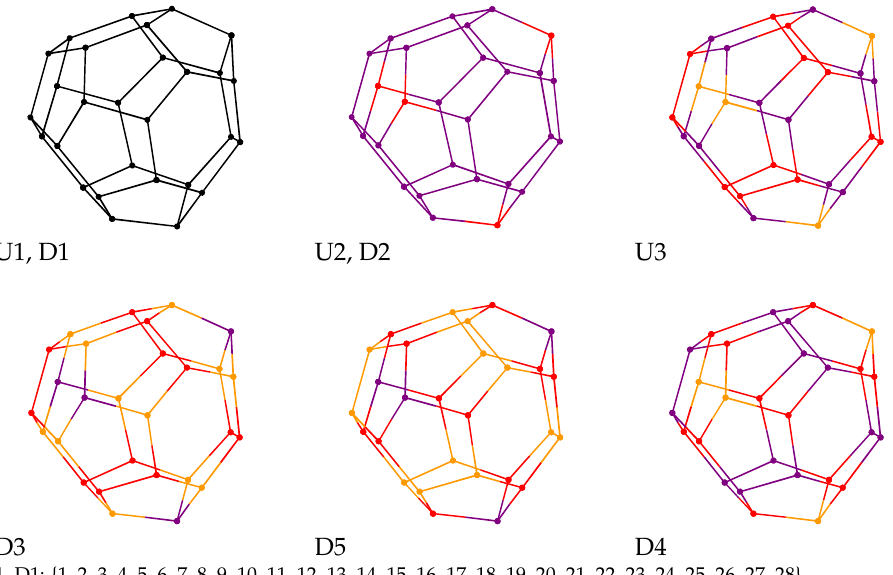
Figure 26. Undistinguishable partitions on C 28 − D 2 from Figure 24.